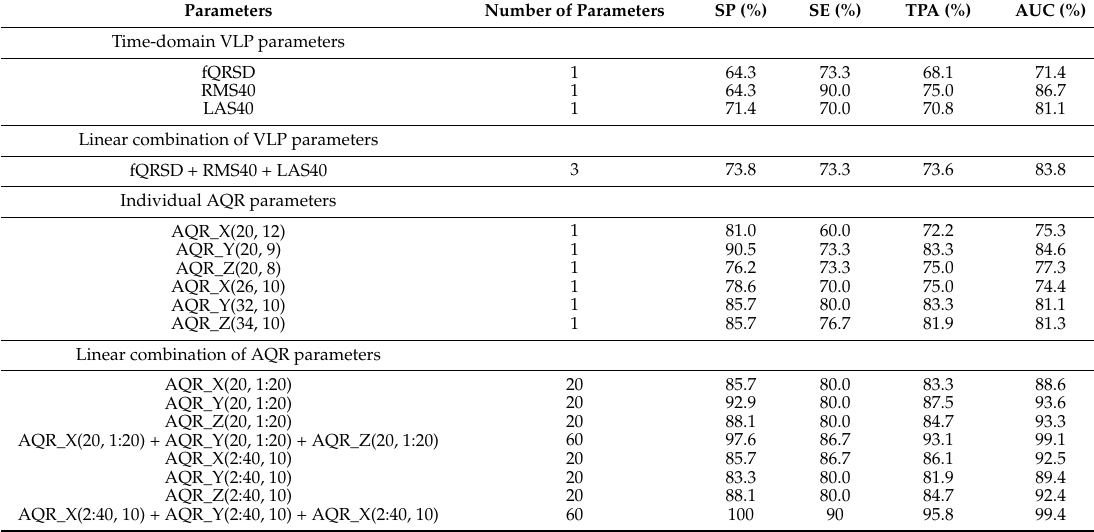
Table 1. Clinical performance of AQR and time-domain ventricular late potentials (VLP)